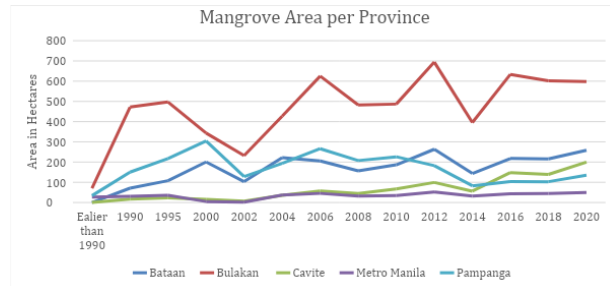
Figure 12. Area of mangroves per province